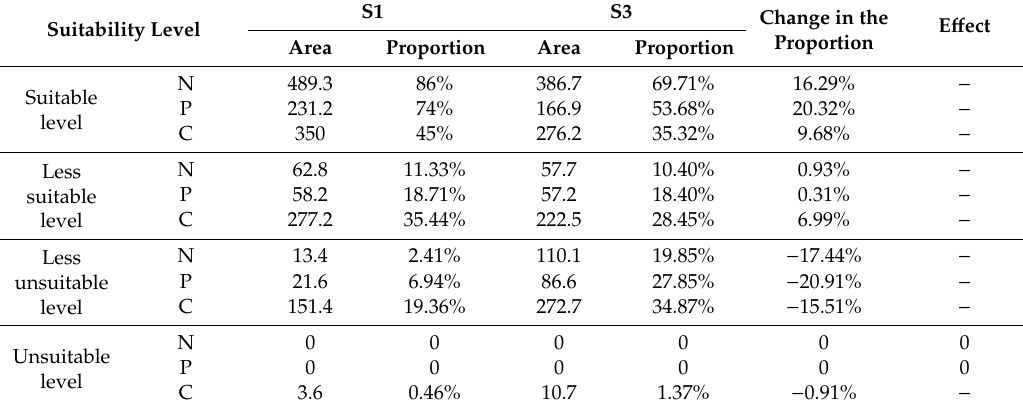
Table 4. Area (km 2 ) and percent change of habitat suitability levels between the studied scenarios at each nature reserve. N, P and C denote the national, provincial and county nature reserves. Percentages were calculated by dividing the area of each reserve by the total area of all nature reserves. Percent change was calculated as “percentage without the hydraulic project” minus “percentage with the hydraulic project”. + and − denote the positive and negative impact, respectively, of the hydraulic project on habitat suitability.